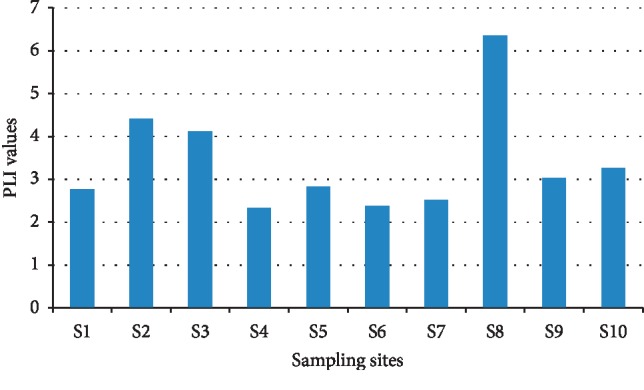
Pollution load index (PLI) values for heavy metals in sampling sites of the Badovci Lake. PLI = 0, perfection; PLI = 1, baseline level; PLI > 1, progressive deterioration [39].